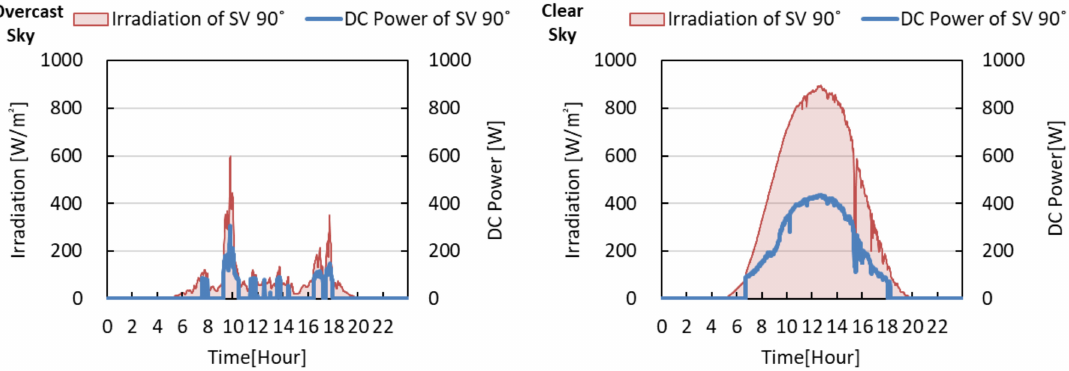
Figure 11. Irradiation and DC power of SV 90 ◦ based on sky